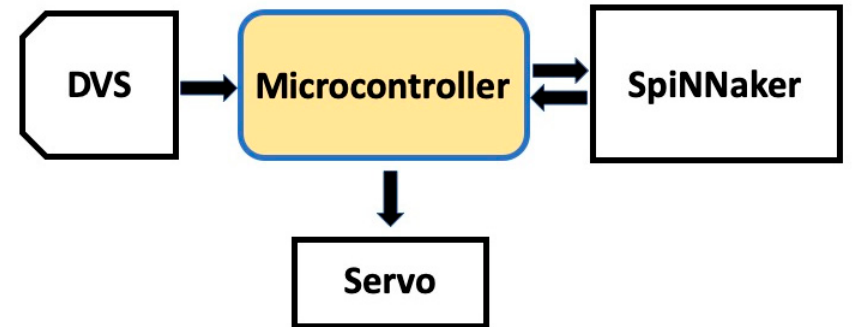
Figure 1. Functional blocks of the neuromorphic platform consisting of dynamic vision sensor (DVS), SpiNNaker board, and servo motor, with the microcontroller implemented as an interface between these blocks.